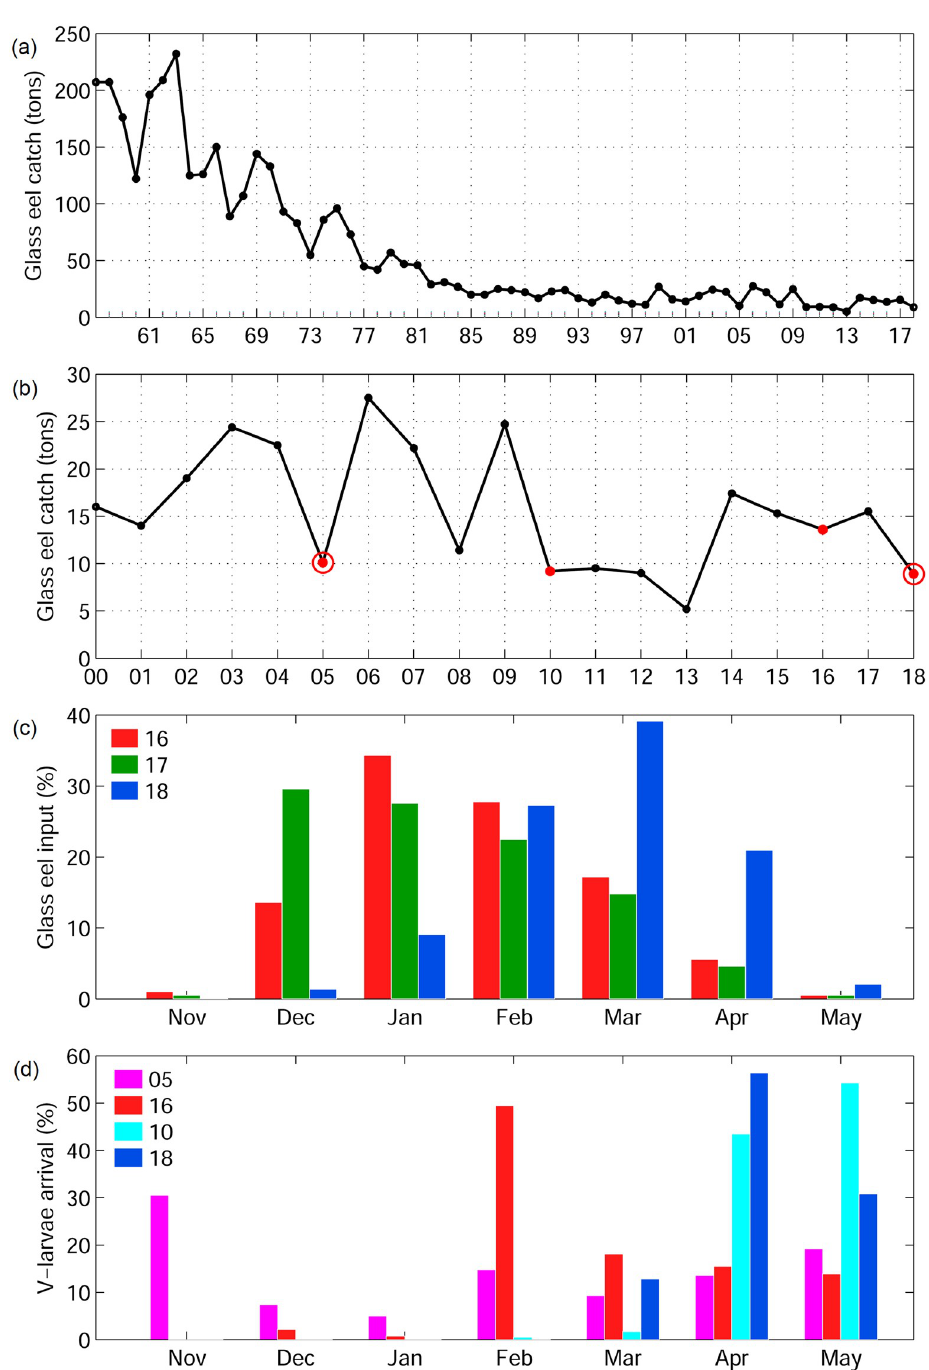
Fig 1. Observed glass eel catches from 1958 to 2018 in Japan (a), since 2000, with the years used in the simulations shown in red and Kuroshio large meander years with red circles (b), and monthly glass eel catches/input (showing percentage of annual catch) in Japan from 2016 to 2018 (c). Simulated monthly v-larvae arrival (%) to southern Japan (d).